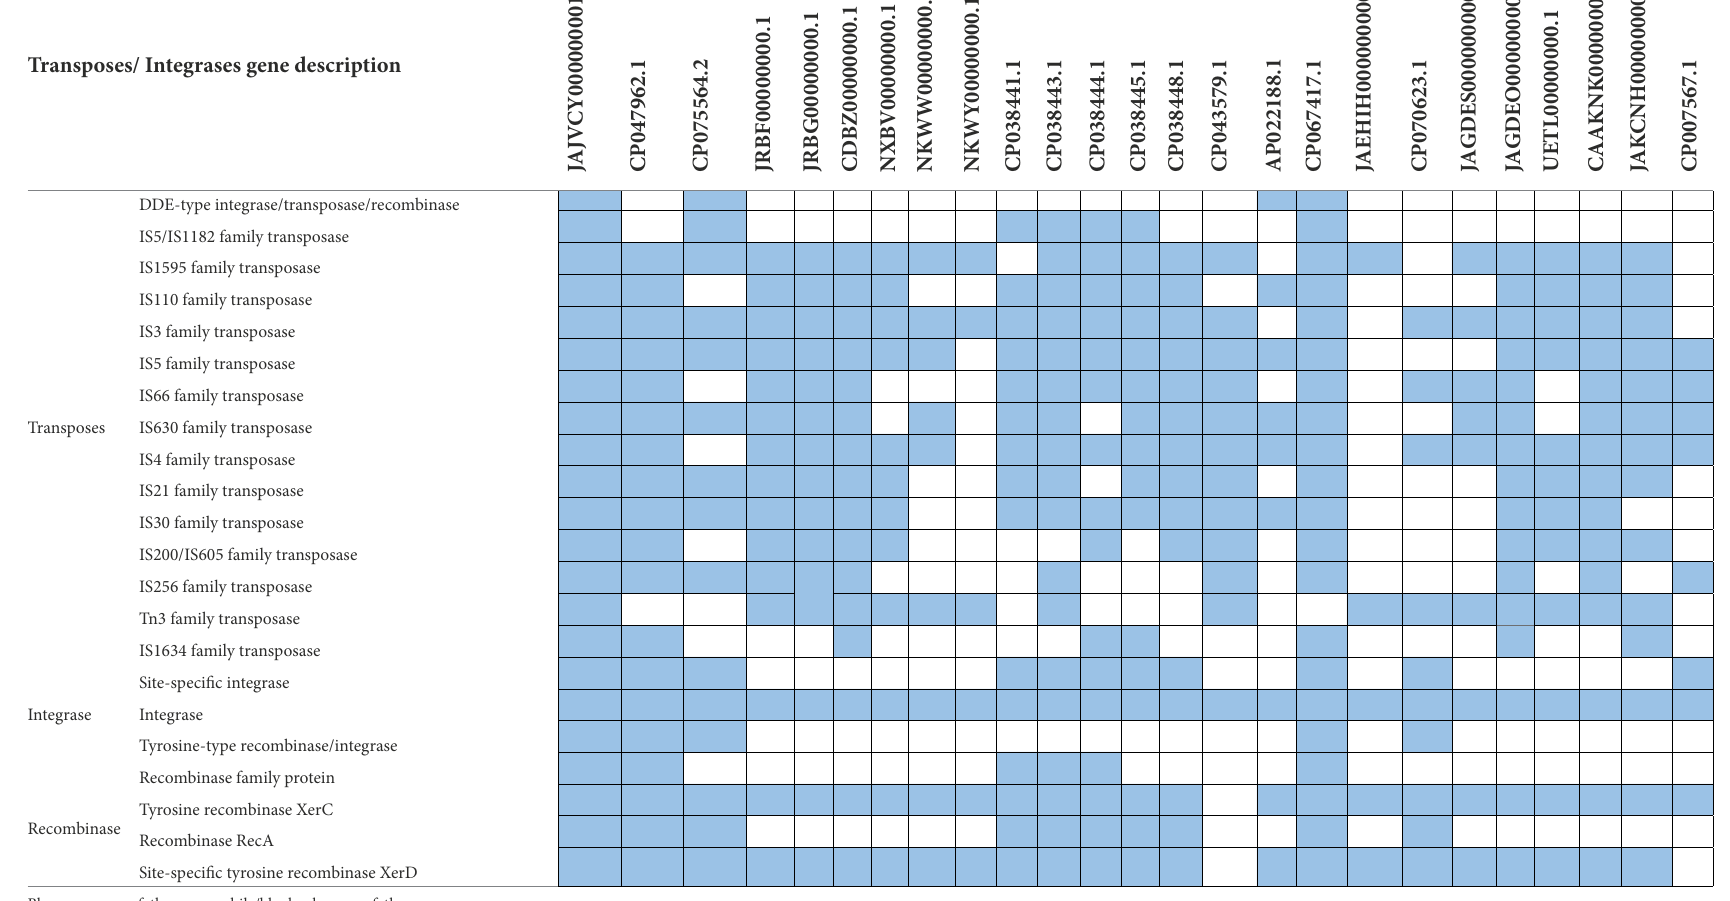
Blue=presence of the gene, while/blank=absence of the